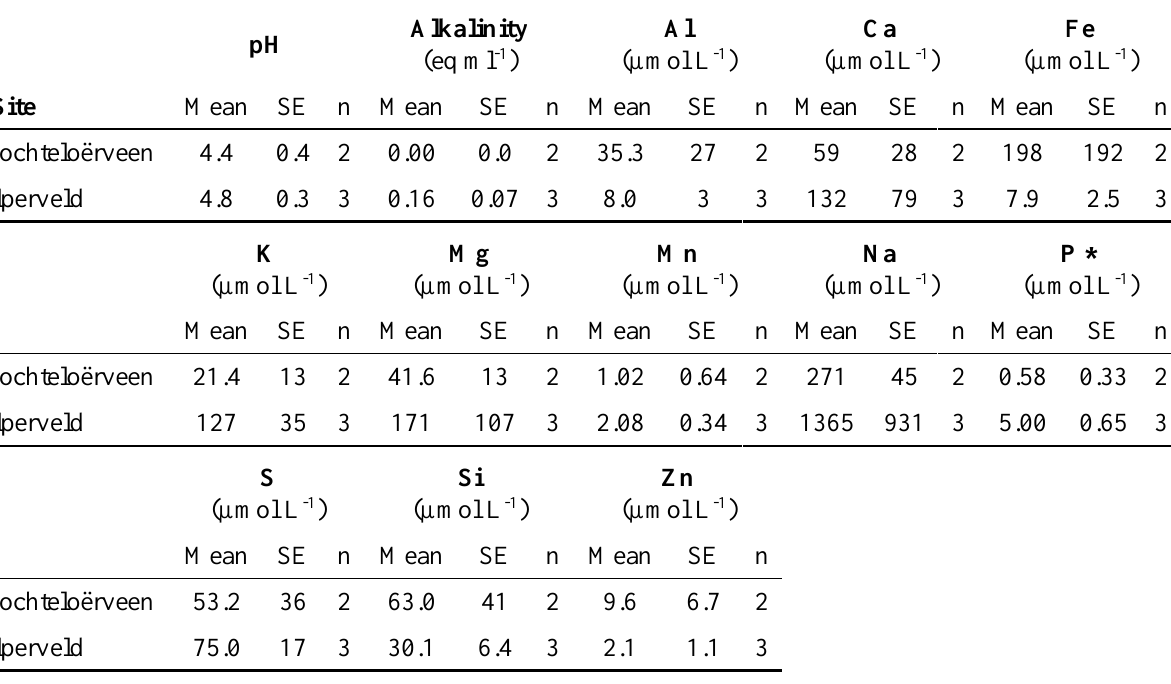
Table A2. Results of the elemental analysis of the pore water using the ICP-OES. Differences between sites were tested with independent t-test. Significant differences are indicated in the title using *.